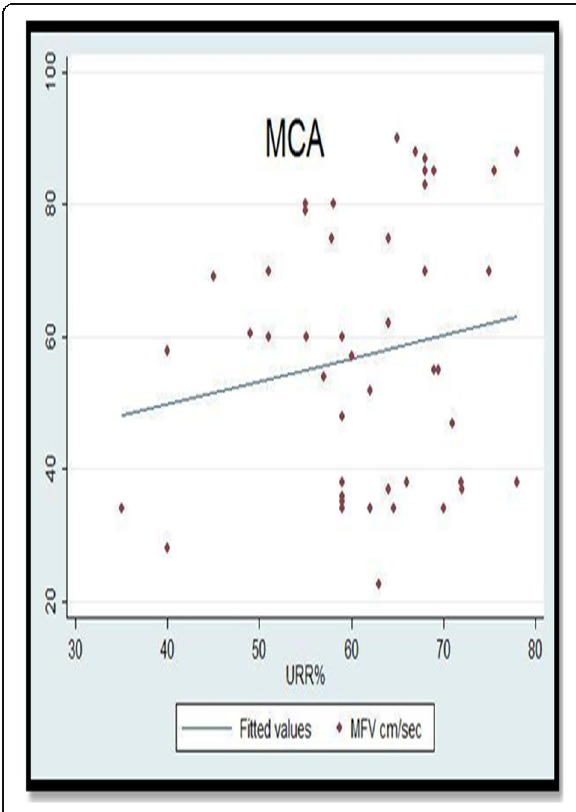
Fig. 1 Correlation between MCA score and URR% ( P < 0.05)